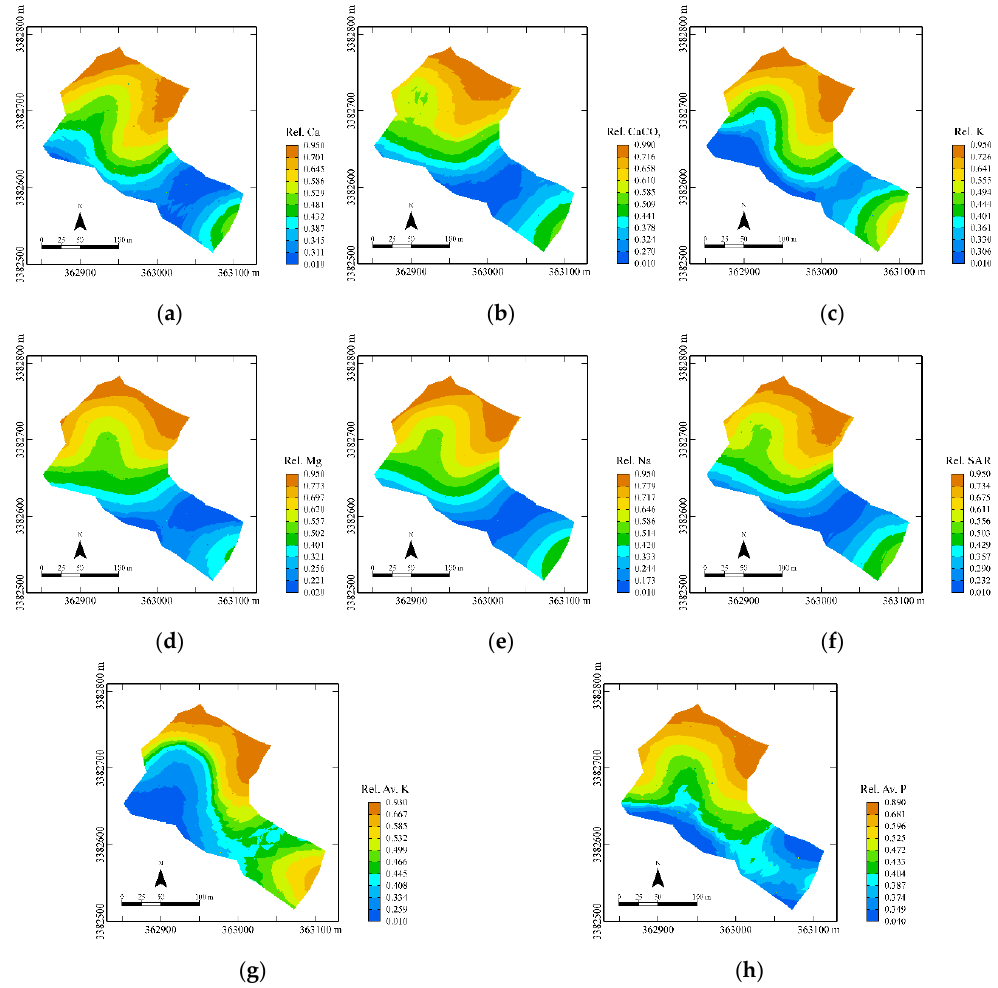
Figure 4. Maps for the auxiliary variables (rank-order transformed). ( a ) Ca, ( b ) CaCO 3 , ( c ) K, ( d ) Mg, ( e ) Na, ( f ) SAR, ( g ) Av. K and ( h ) Av. P.